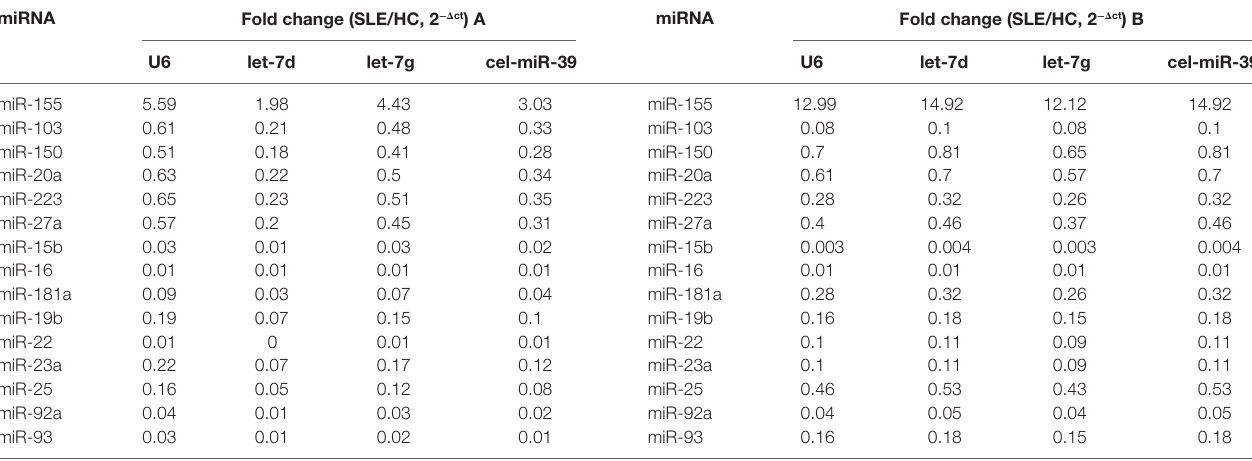
TaBle 3 | Differential expression of B cells-associated microRNAs (miRNAs) in the plasma of systemic lupus erythematosus (SLE) patients and healthy control (HC). mirna Fold change (sle/hc, 2 −Δ ct ) a mirna Fold change (sle/hc, 2 −Δ ct ) B